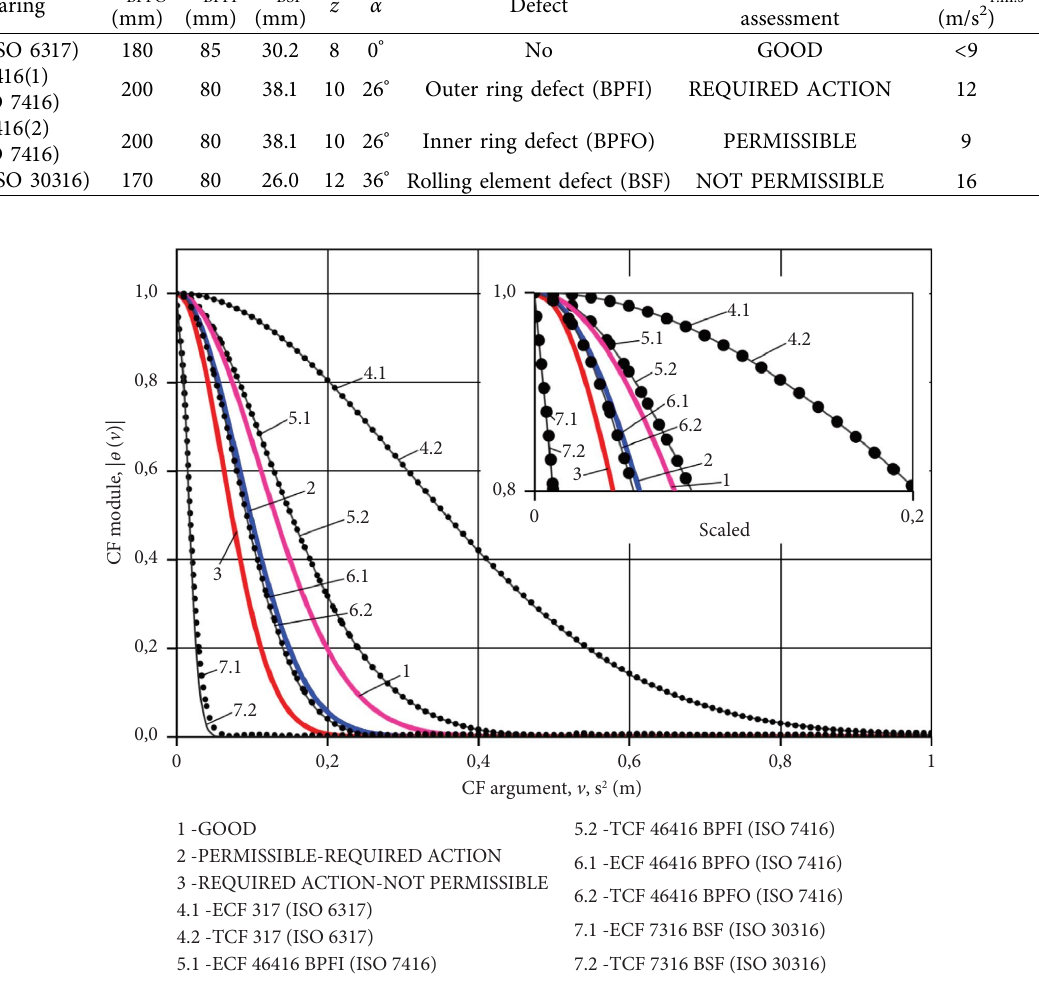
Figure 4: Teoretical CF (TCF) and empirical CF (ECF) of VA signals of the studied